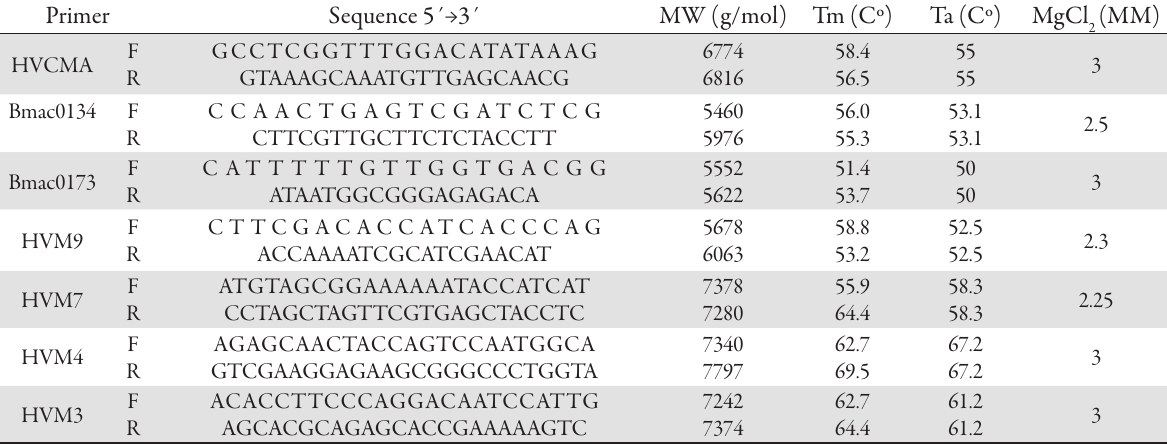
Tab. 1. Polymerase chain reaction primers and their